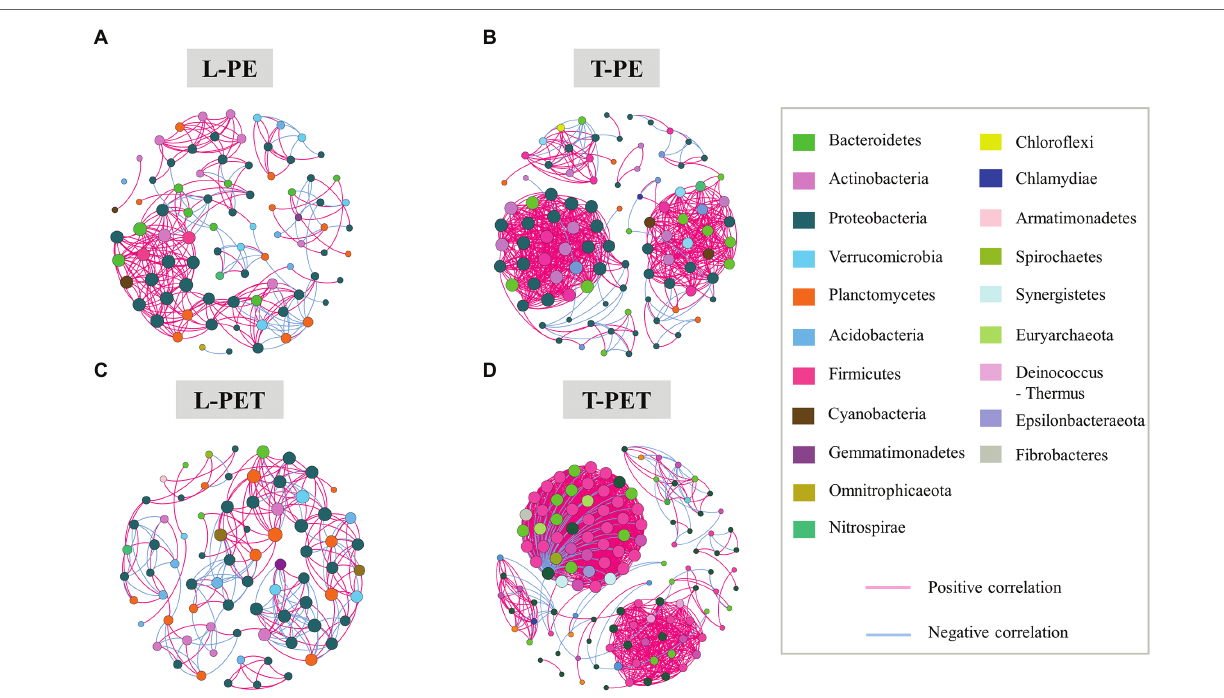
FIGURE 5 | Co-occurrence networks of MPB bacterial communities in L-PE (A) , T-PE (B) , L-PET (C) , and T-PET (D) sample groups based on correlation analysis. Each node represents one OTU, of which the size is proportional to the number of connections (i.e., degree) and the color represents bacterial taxonomy at the phylum level. An edge represents significantly strong ( p < 0.05; Pearson’s correlation coefficient r > 0.9) correlation (purple for positive correlation and blue for negative correlation) between bacterial